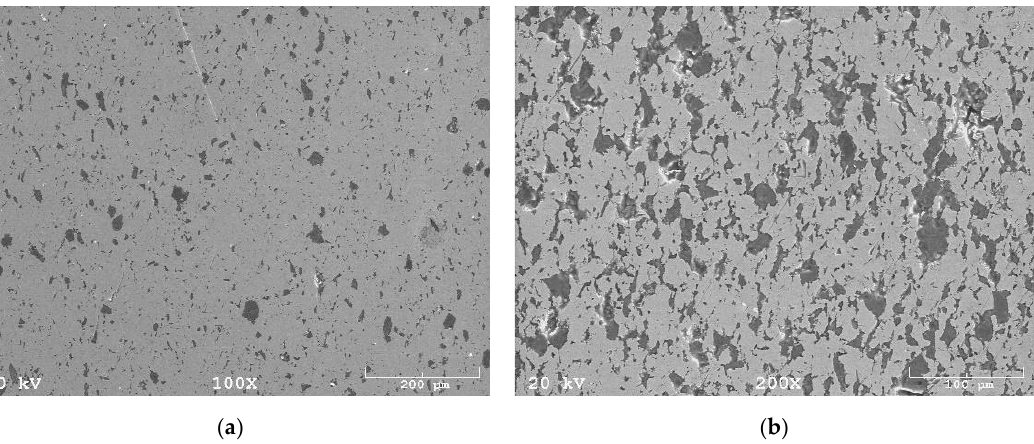
Figure 10. Microstructure of composites with: ( a ) 5% wt. of tuff at a magnification of 100×; ( b ) 30% wt. of tuff at a magnification of 200X [33].